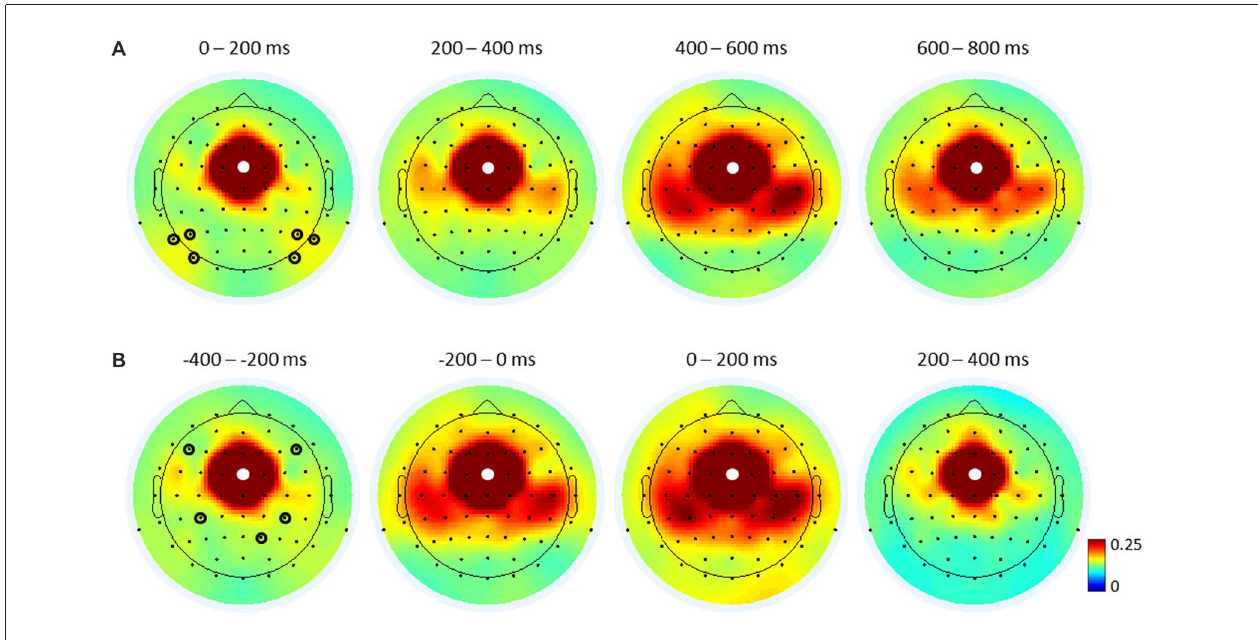
FIGURE 4 | Topographical maps of FCz-seed inter-channel phase synchronization (ICPS) in theta oscillations. Stimulus-locked (A) and response-locked (B) ICPSs, averaged over all trials and participants for the respective time-windows. White dots represent the seed electrode FCz. Black circles indicate electrodes of interest used for FCz-seed ICPS analyses (see Figures 5 , 7 ): six electrodes (P5/6, P7/8, PO7/8) in (A) cover the parieto-occipital cortex, and two upper electrodes (F5/6) in (B) cover the dorsal lateral prefrontal cortex (DLPFC), two midline electrodes (CP3/4) cover the motor cortex, and one bottom electrode (P2) covers the right parietal